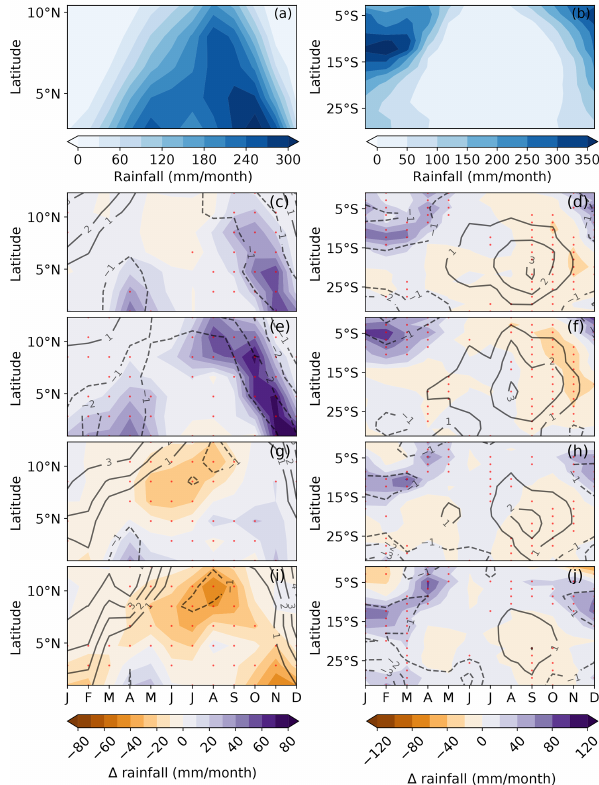
Figure 8. Hovmöller diagrams for the African continent domains. The left column corresponds to the NAF domain (a, c, e, g, i) and the right column to the SAF domain (b, d, f, h, j) . Panels (a, b) cor- respond to the precipitation values in millimetres per month over the historical period (1976–2005). All other diagrams correspond to the difference between the future scenario (2041–2070) and the his- torical period (1976–2005) for precipitation (colours) and (cid:49) MSE (black contours, dashed lines for negative values). Future scenarios are (c, d) RCP8.5, (e, f) WAIS3m, (g, h) GrIS1m and (i, j) GrIS3m. Significant differences at the 95% confidence interval are depicted by red dots according to the Wilcoxon–Mann–Whitney test (see Sect.